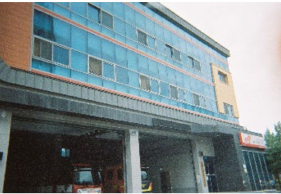
Figure 14. Korean 911(119).